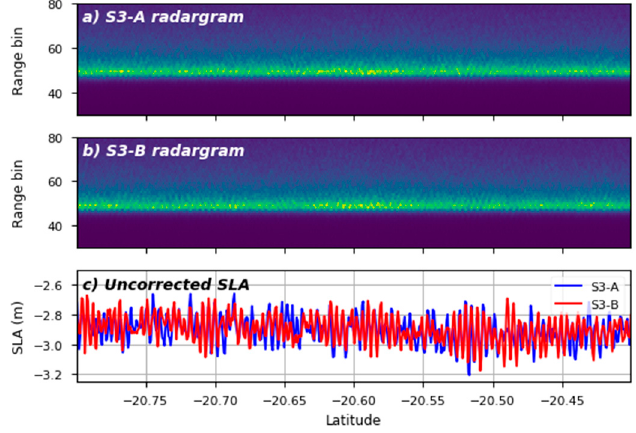
Figure 12. S3-A and S3-B radargrams exhibiting distorted waveforms and SLA oscillations due to aliasing. Reprinted from [16].